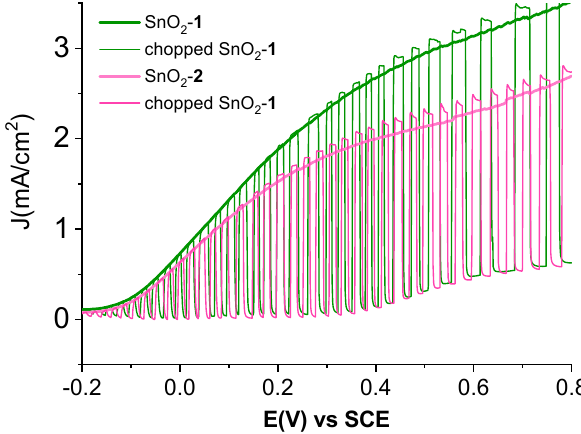
Figure 7. J/E curves in the presence of 0.1 M AA under AM 1.5G illumination. Illumination from the FTO side, potential sweep rate 10 mV/s.